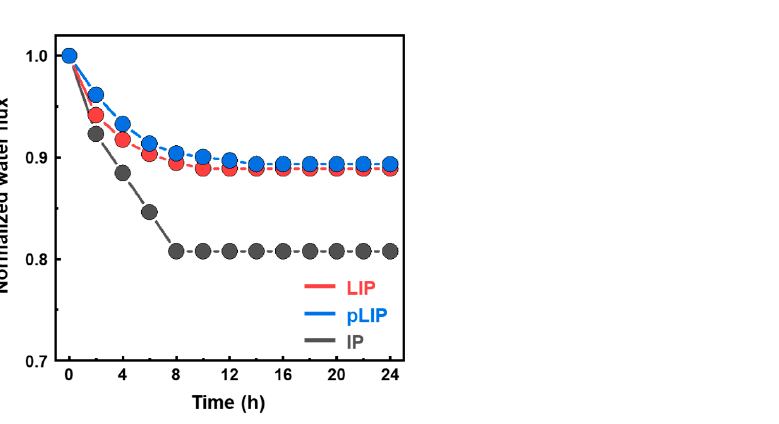
Figure 6. Morphologies of the fabricated membranes. ( a – c ) SEM surface, ( d – f ) AFM surface (with rms surface roughness), and ( g – i ) TEM cross-sectional images of the ( a , d , g ) LIP, ( b , e , h ) pLIP, and ( c , f , i ) conventional IP membranes.